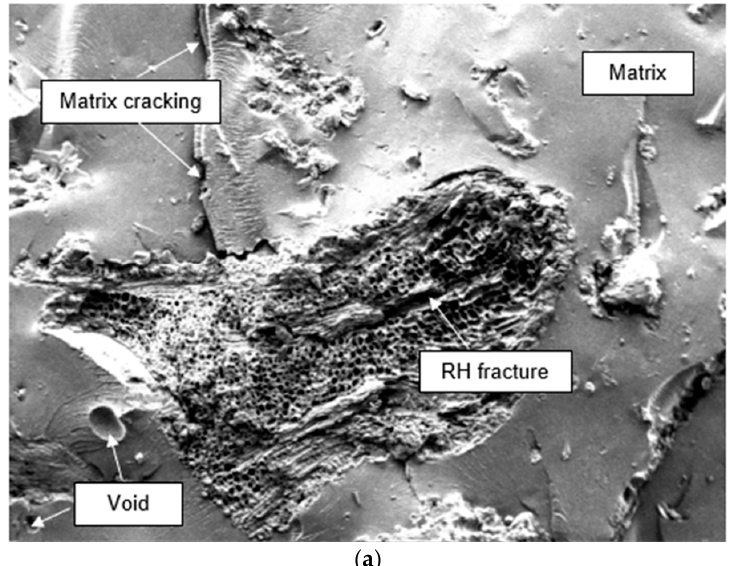
Figure 7. Impact behaviour of RH/CP reinforced ABS blend composites.